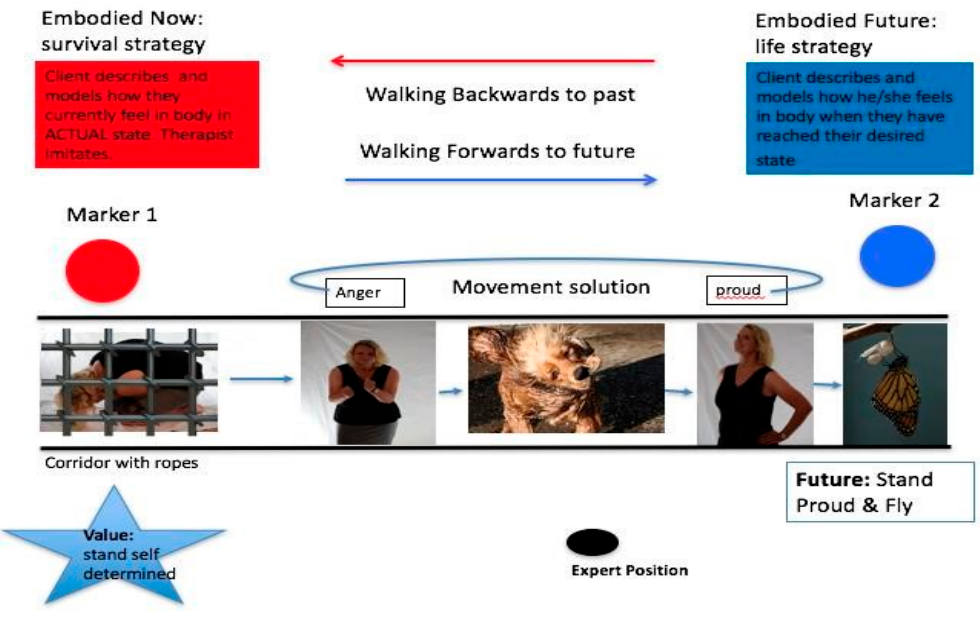
Figure 3. Emotional acceptance and mastery.